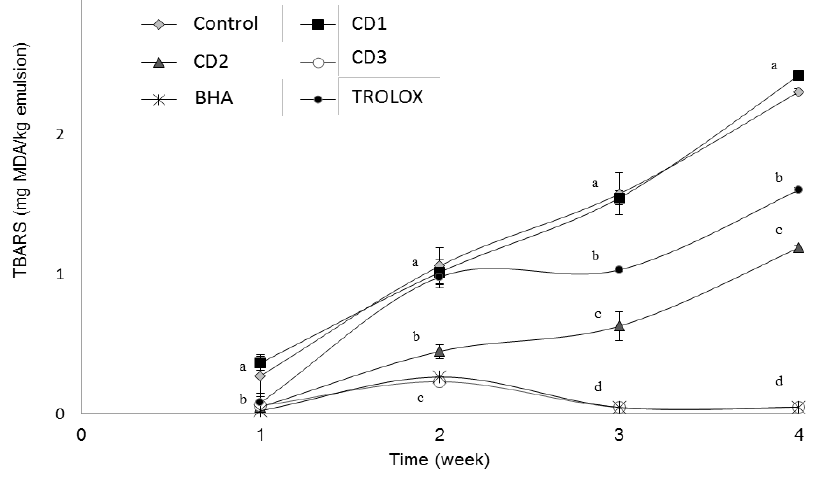
Figure 4. Changes in TBARS values of emulsions during the study. Bars represent standard deviation ( n = 3). Different letters in the same day (a, b, c, d) indicate significant differences between samples.